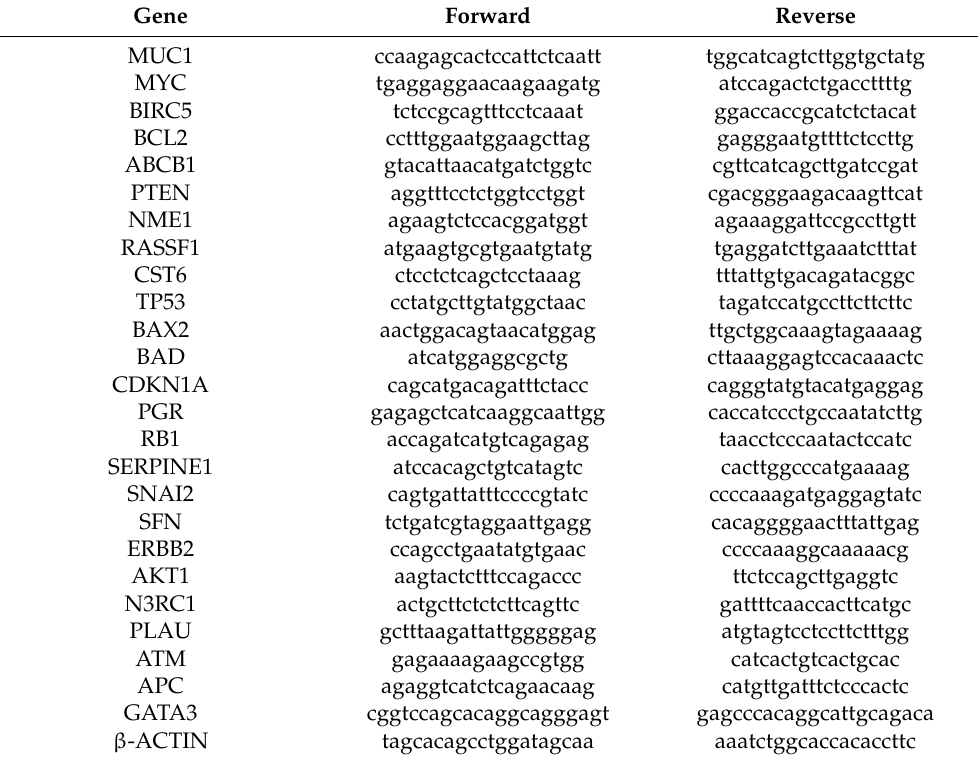
Table 1. Primer sequences of genes tested by real-time